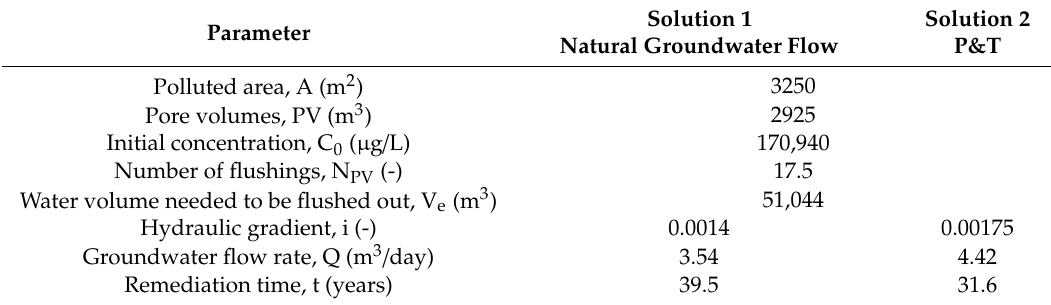
Table 7. Batch flushing model results for the synthetic